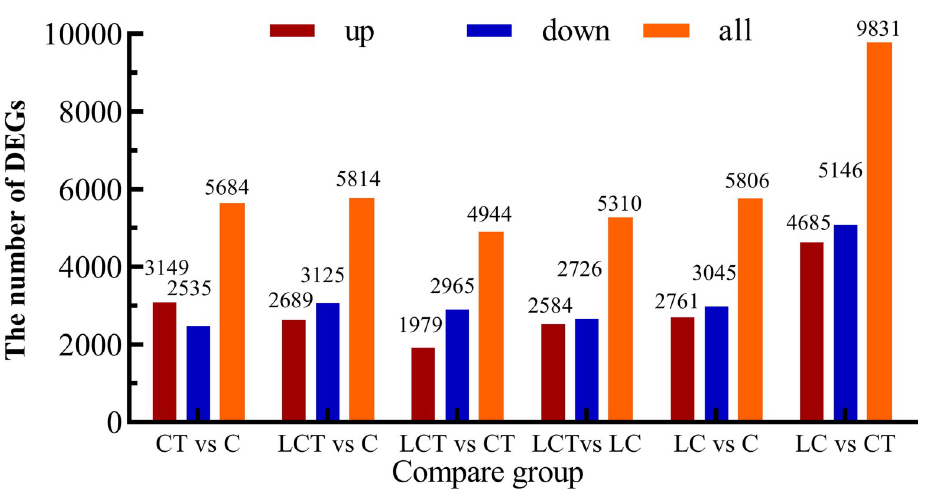
Fig 4. Statistical histogram of the number of genes in different